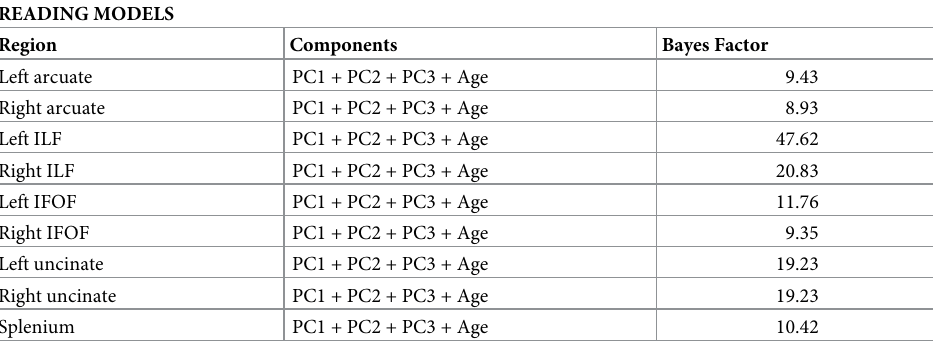
Table 3. Bayes factors assessing the likelihood of the null hypothesis condition (no relationship between Total Reading scores and model components) versus the likelihood of the model condition (relationships between included components and Total Reading).